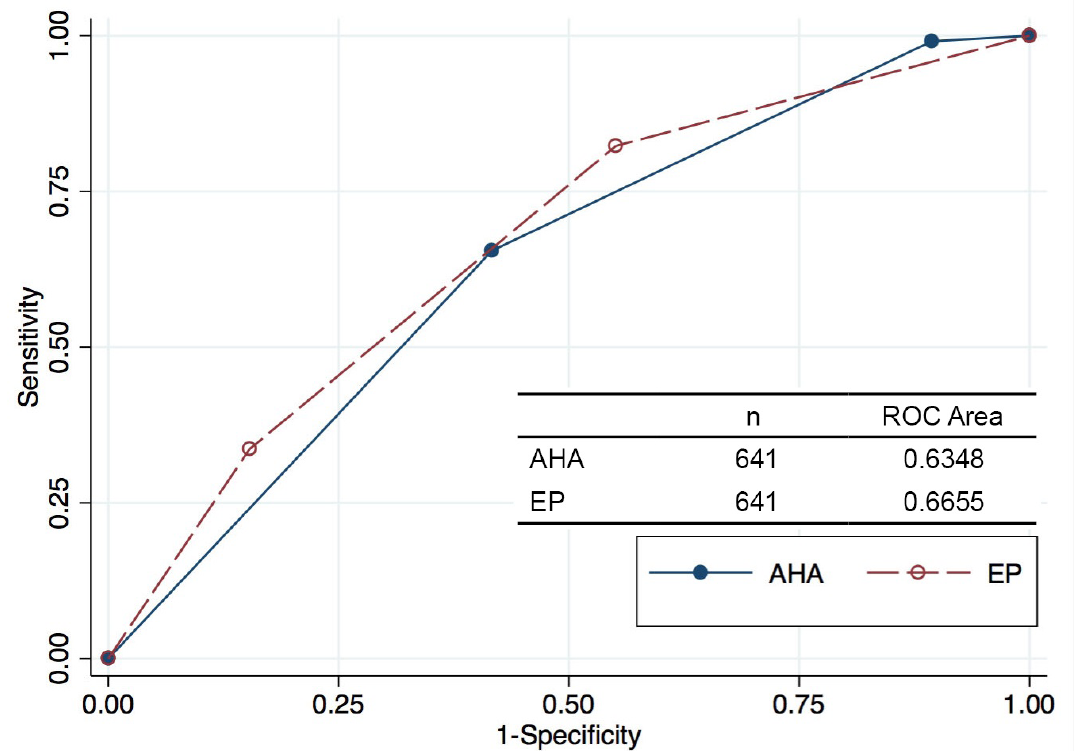
Figure 2. Receiver operating characteristic curve comparing AHA/ACC/ACEP to emergency physician risk